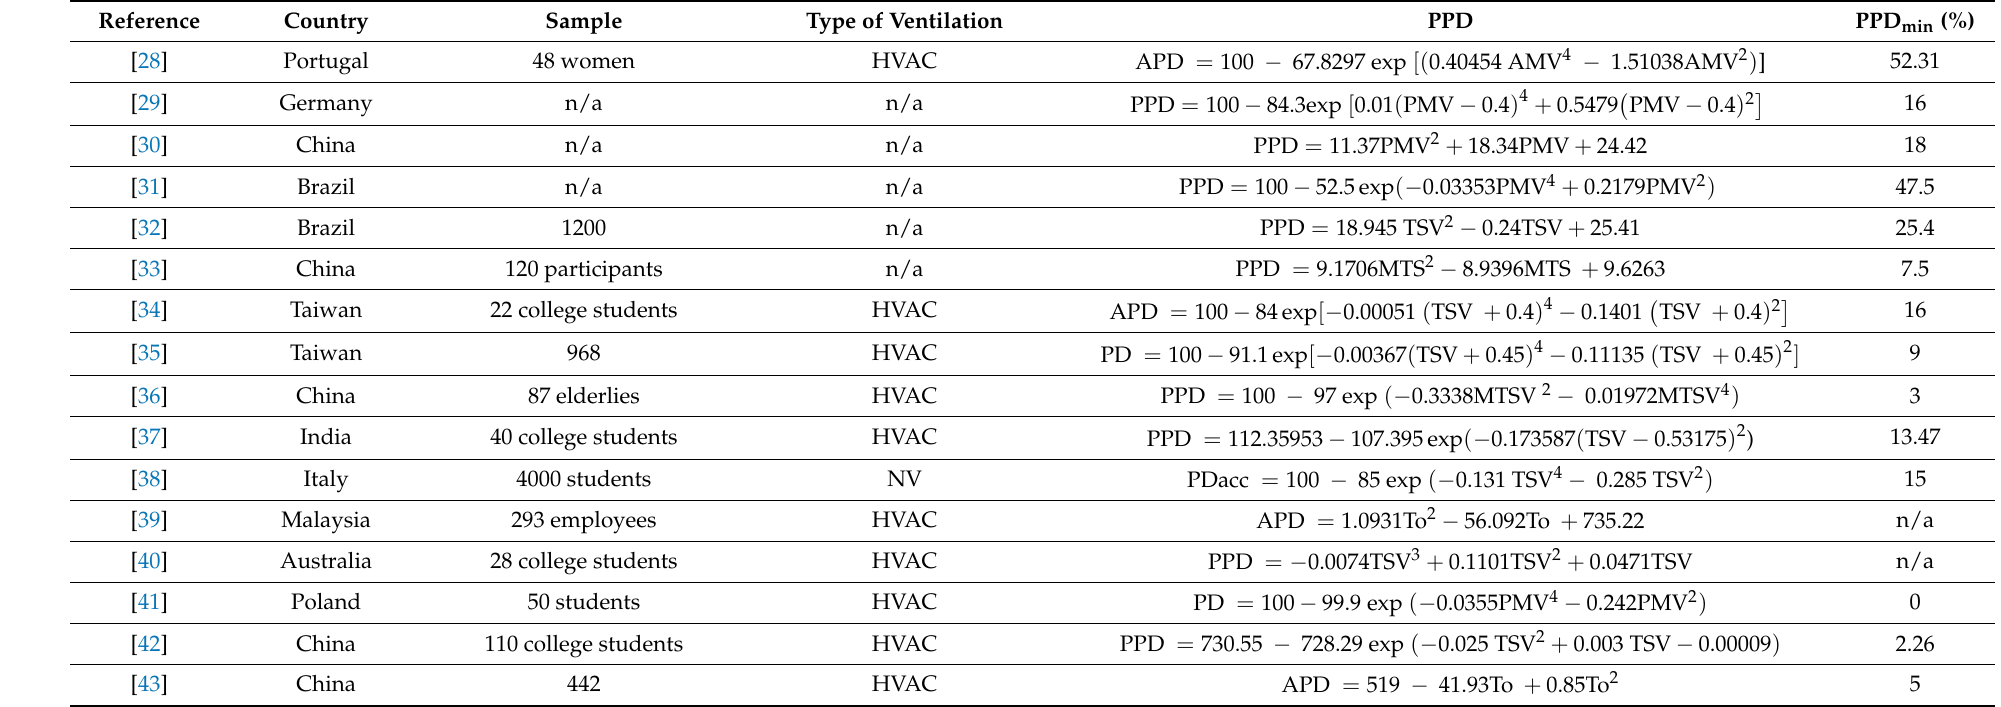
Table 1. Alternative models for the predicted percentage of